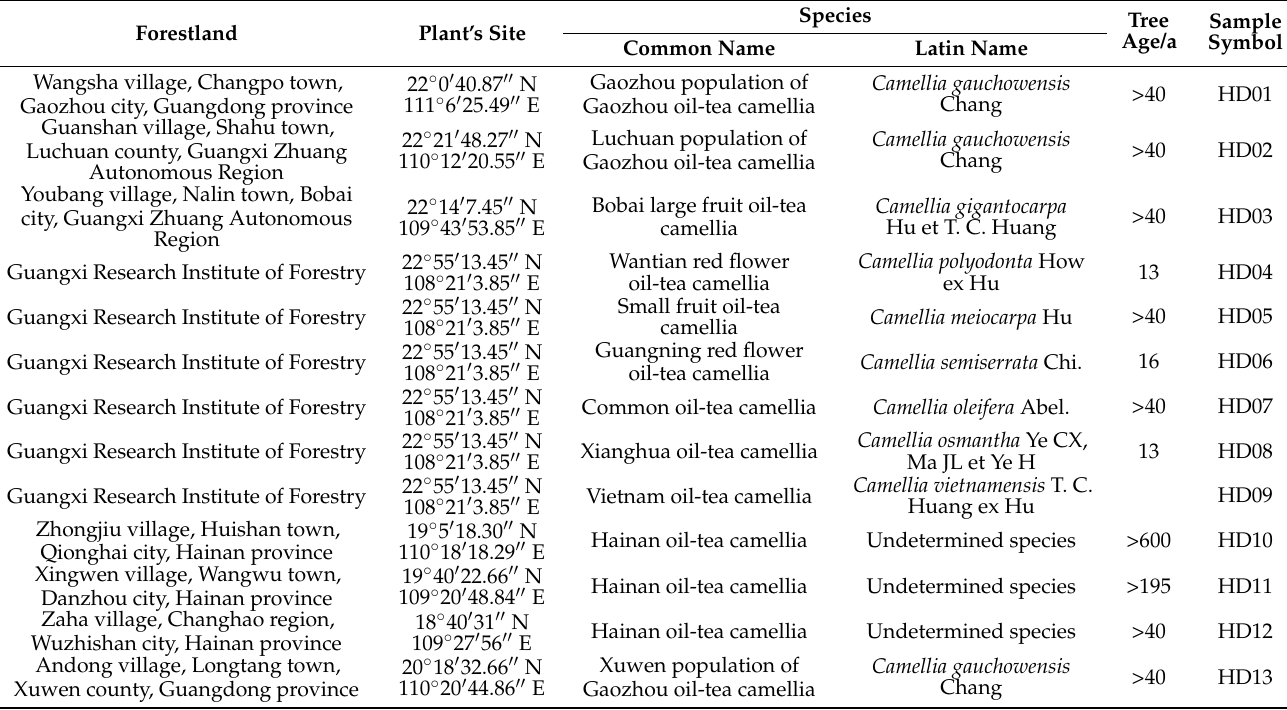
Table 1. Basic information on the different oil-tea camellia